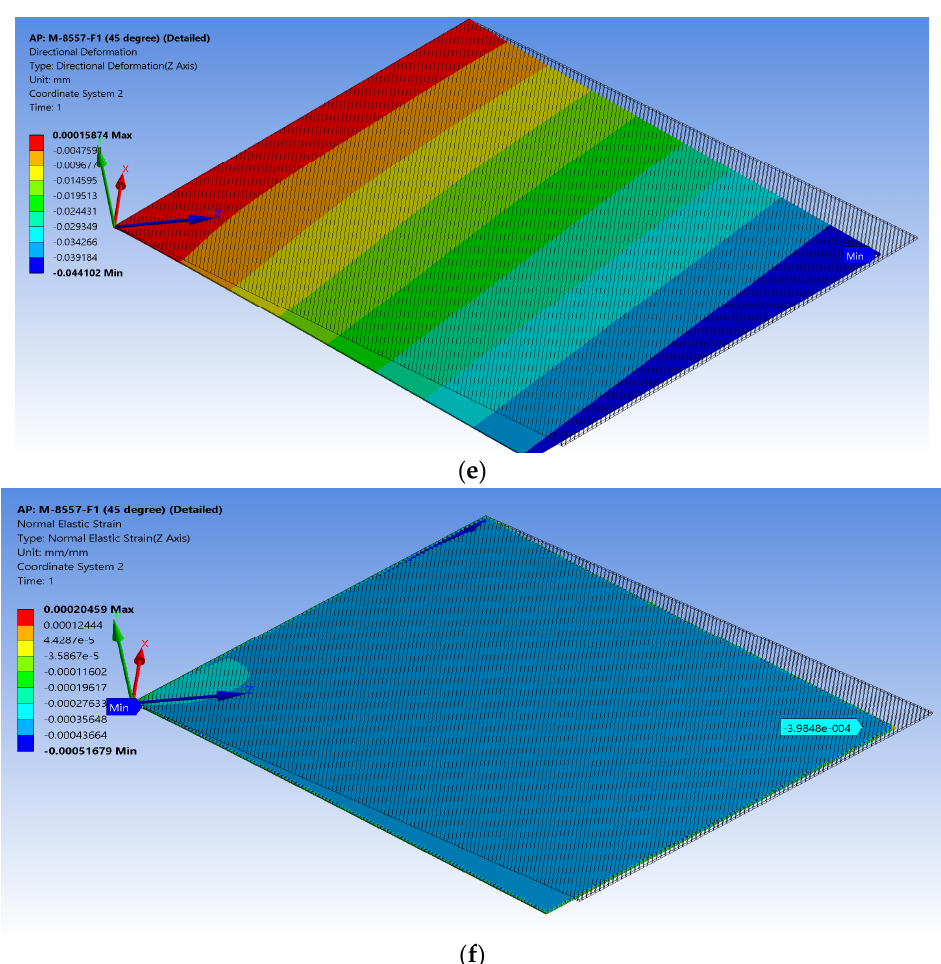
Figure 6. Detailed FE model of M-8557-F1 showing ( a ) applied voltage difference of 1500 V for every segment, ( b ) the generated electric field of about ±3 × 10 6 V/m, ( c ) the result for elongation displacement in the z -axis, ( d ) the result for max elongation strain, ( e ) the result for compressive displacement in the z -axis, and ( f ) the result for max compressive strain.